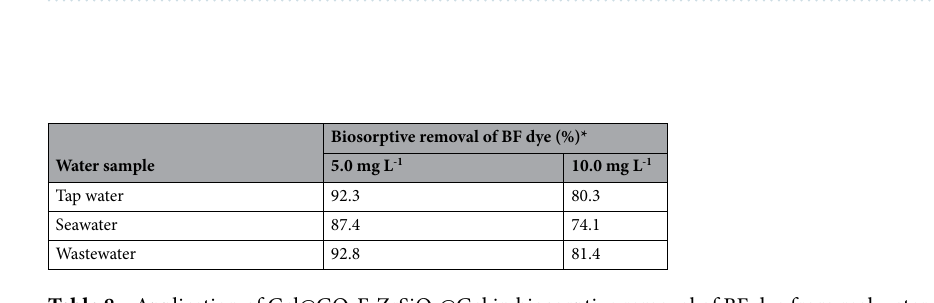
Table 8. Application of Gel@GO-F-ZrSiO 4 @Gel in biosorptive removal of BF dye from real water samples. *Values are based on triplicate analysis with ± 0.2–0.6%.